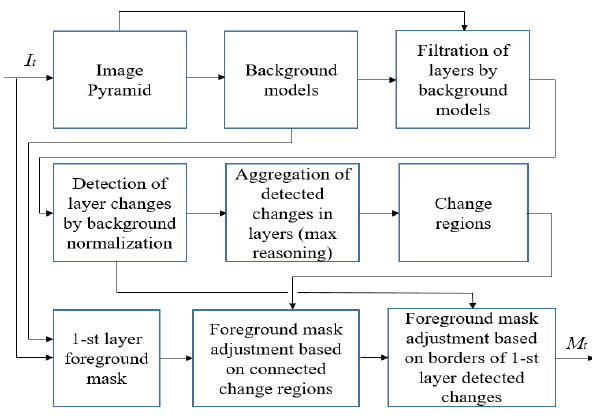
Figure 2. The flowchart of our approach to change detection